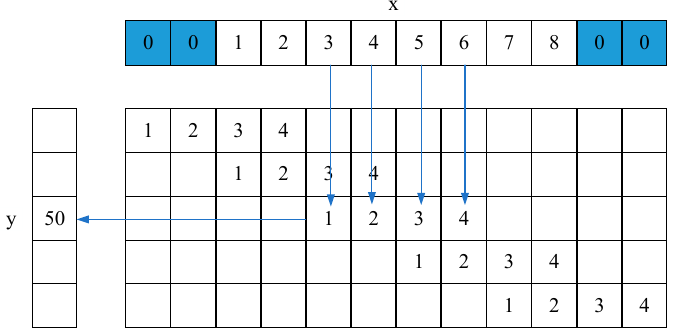
Figure 5. The one ‐ dimensional convolution calculation process. Figure 5. The one-dimensional convolution calculation